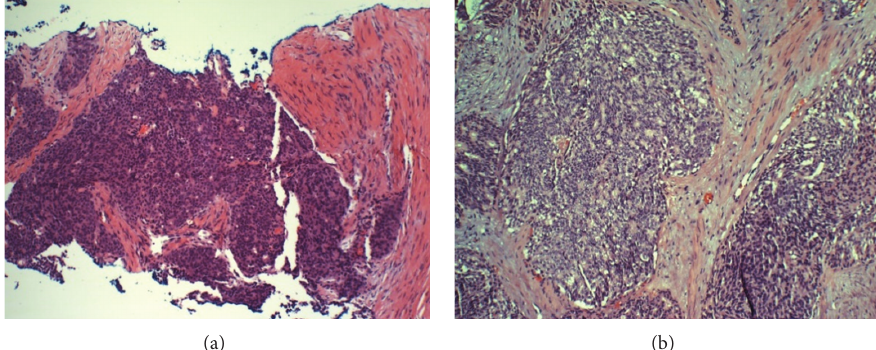
Figure 2: Biopsies of corpus cavernosum (a) and bladder neck mass (b), both demonstrating poorly differentiated prostatic